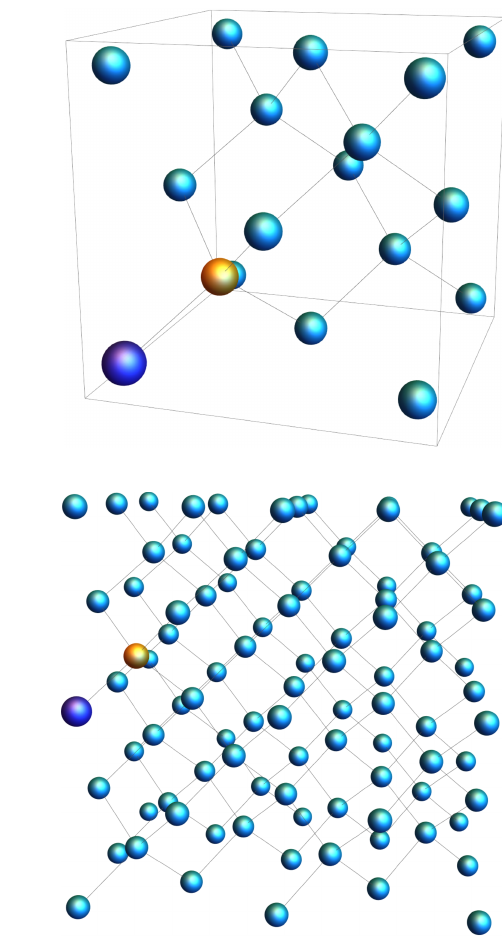
Figure 1. The USP falling on the presented system, in case ( a ) A diamond lattice unit cell with one NV center, where blue is carbon atoms ( C ), purple is a nitrogen atom ( N ), and yellow is a vacancy; ( b ) a diamond lattice with one NV center for 8 unit cells (2 × 2 ×